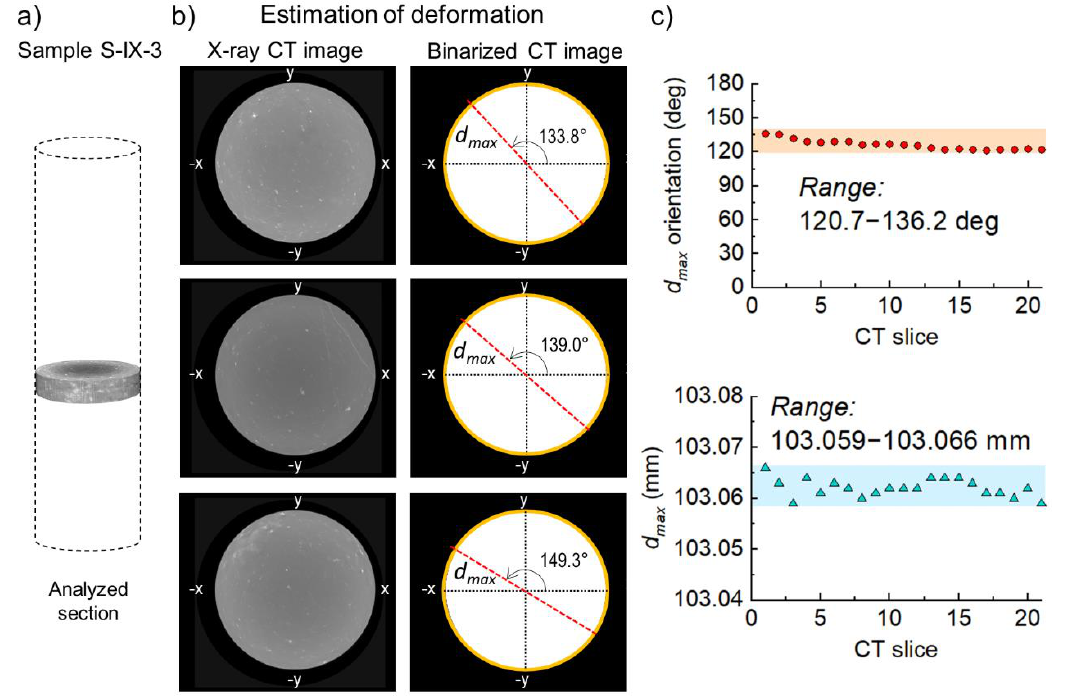
Figure 4. ( a ) X-ray 3D rendered section of sample S-IX-3. ( b ) Process of diametrical estimation using CT slices and ellipse fitting tools at three different heights. The images were first binarized, and later a best-fitting process allowed obtaining maximum and minimum deformations and their orientations. ( c ) The results of d max orientation and d max values for the analyzed CT cross sections fell into relatively small ranges.